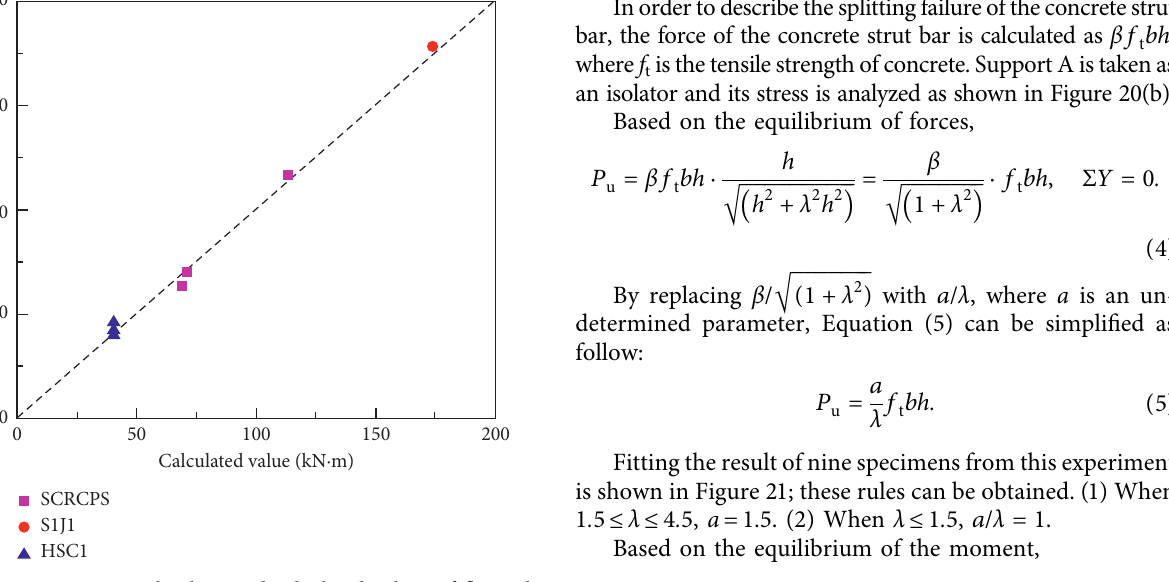
Figure 19: Experimental values and calculated values of flexural